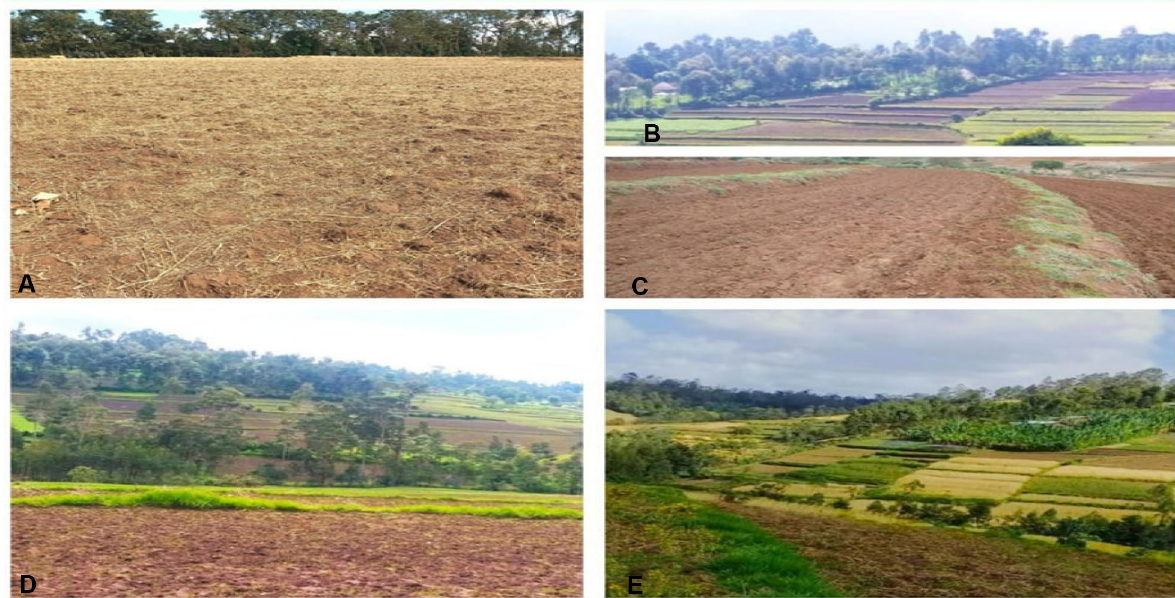
Fig. 3 Sample site pictures (from right to left): non-treated (NT), land treated with only physical ALM practices for 5 years (ToP5Y), land treated with only physical ALM practices for 10 years (ToP10Y), land treated with integrated ALM measures for 5 years (TIN5Y) and land treated with integrated ALM measures for 10 years